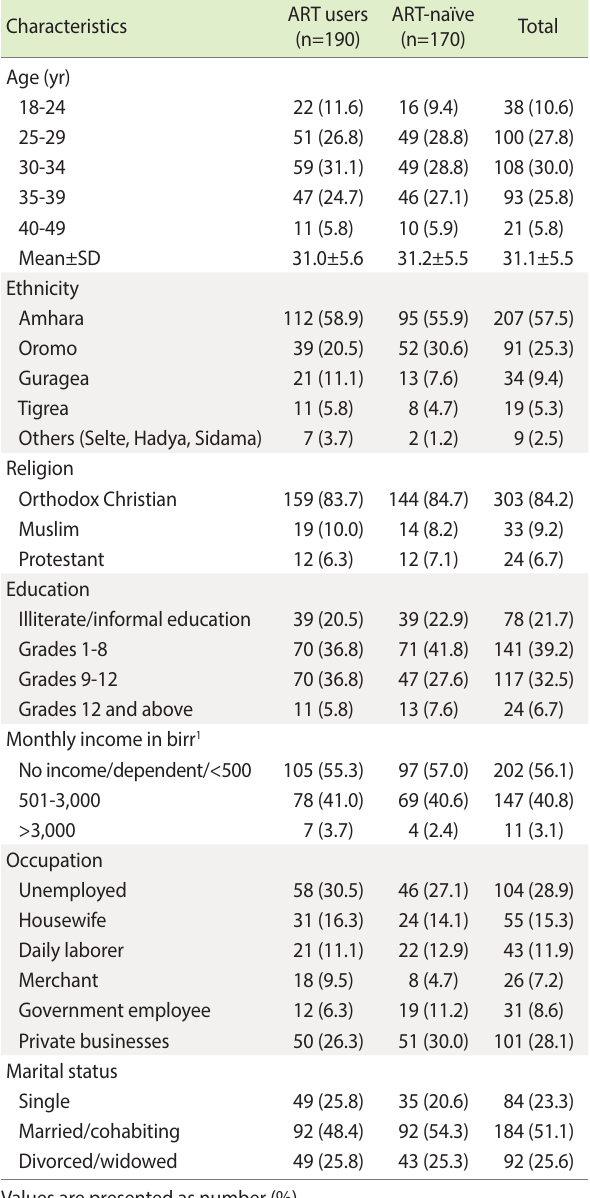
Table 1. Socio-demographic characteristics of HIV-positive women in Addis Ababa, Ethiopia